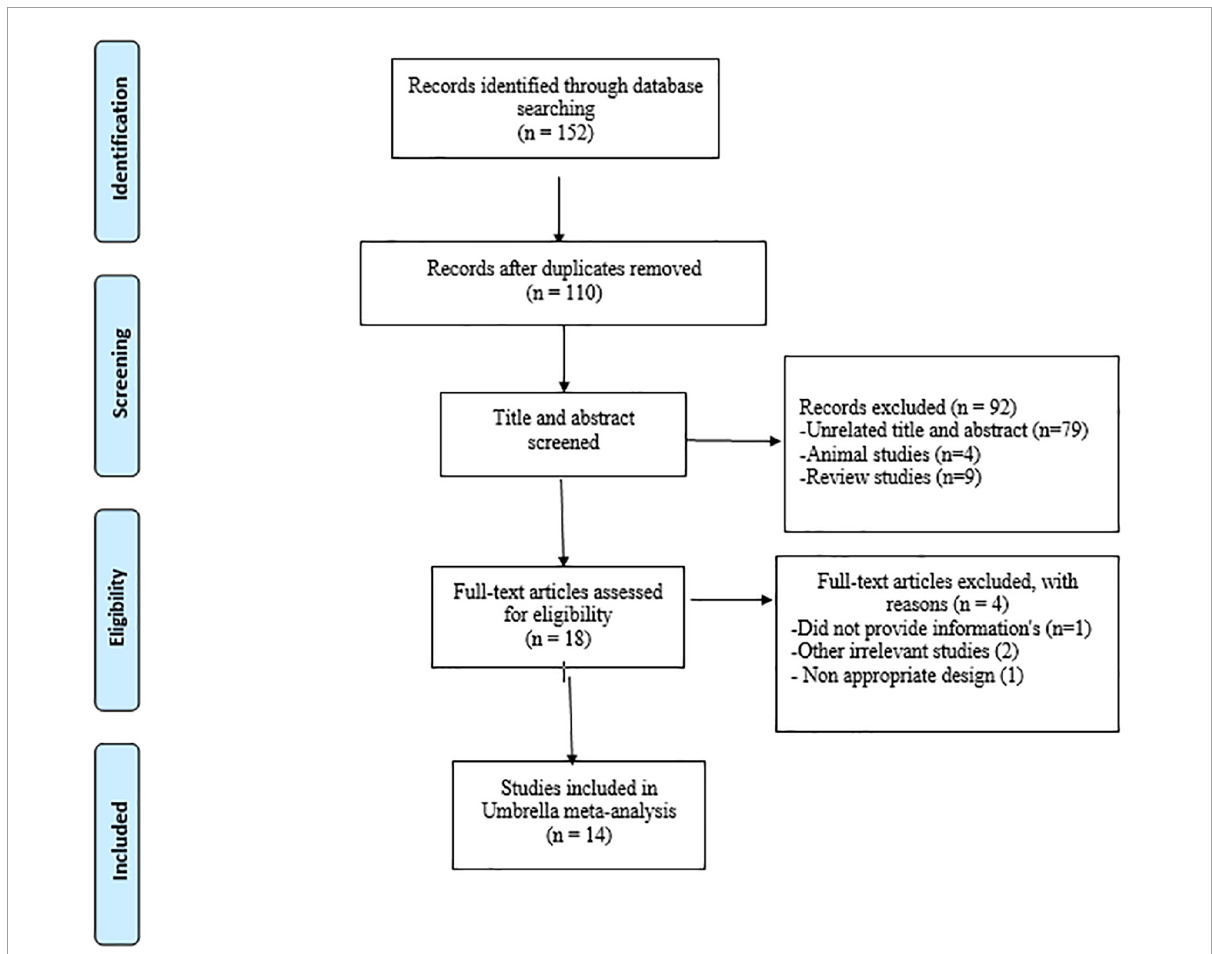
FIGURE1 Flowchart of the study